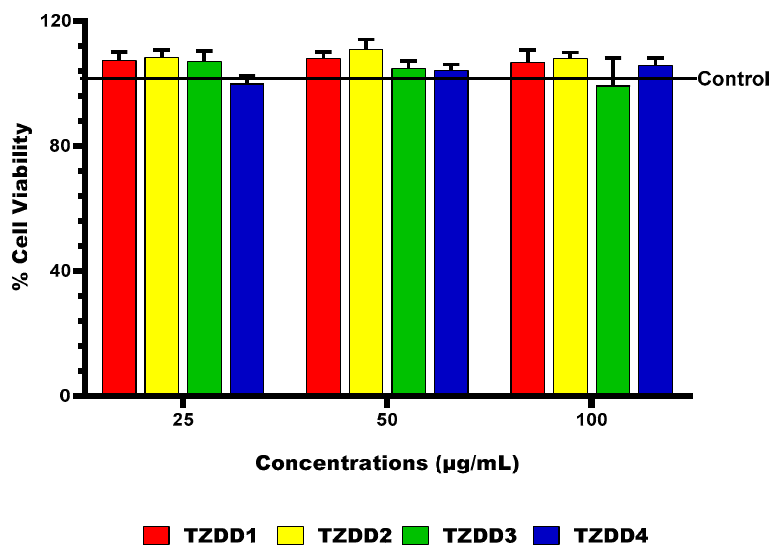
Figure 8. Cell viability expressed as a percentage of cells viable after 24 h exposure to the investigated derivatives at different concentrations to those in the untreated sample (control). The results are represented in a clustered column. Data are presented as mean ± standard deviation values. The error bars correspond to the standard errors of the means.